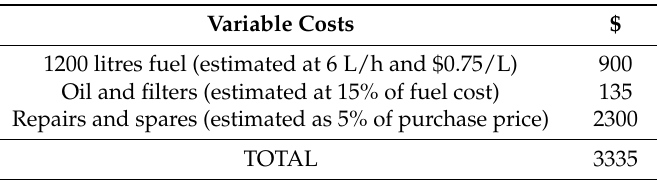
Table 3. Annual variable costs of tractor